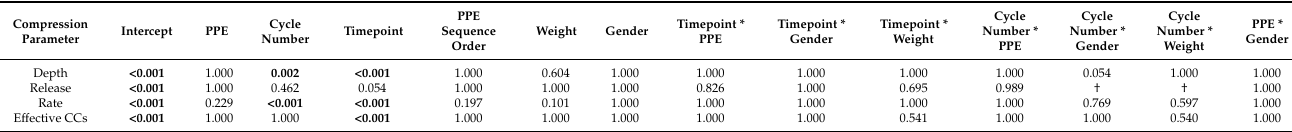
Table 3. Here, p -values of the factors are inserted in the generalised estimating equations# (GEE) for analysis of the compression parameters; the p -values are corrected by means of the Holm–Bonferroni method. Compression Parameter Intercept Depth <0.001 <0.001 PPE—personal protective equipment; CCs—chest compressions. * An asterisk between two factors denotes an interaction. # The specified distribution and link function were normal and identified for the chest compression depth and rate, Gamma and the logarithm for chest compression release, and Poisson and the logarithm for the number of effective chest compressions; the working correlation matrix was chosen by means of the Quasi-Likelihood under Independence Model Criterion (QIC) among 1-dependent, independent, unstructured and first-order autoregression (AR(1)) and was independent for chest compression depth, rate and release and AR(1) for the number of effective chest compressions. † Not calculated because of computational issues. The participants appraised higher fatigue with PPE in comparison to without PPE